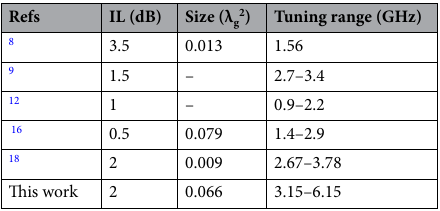
Table 2. Comparison between the proposed filter and other